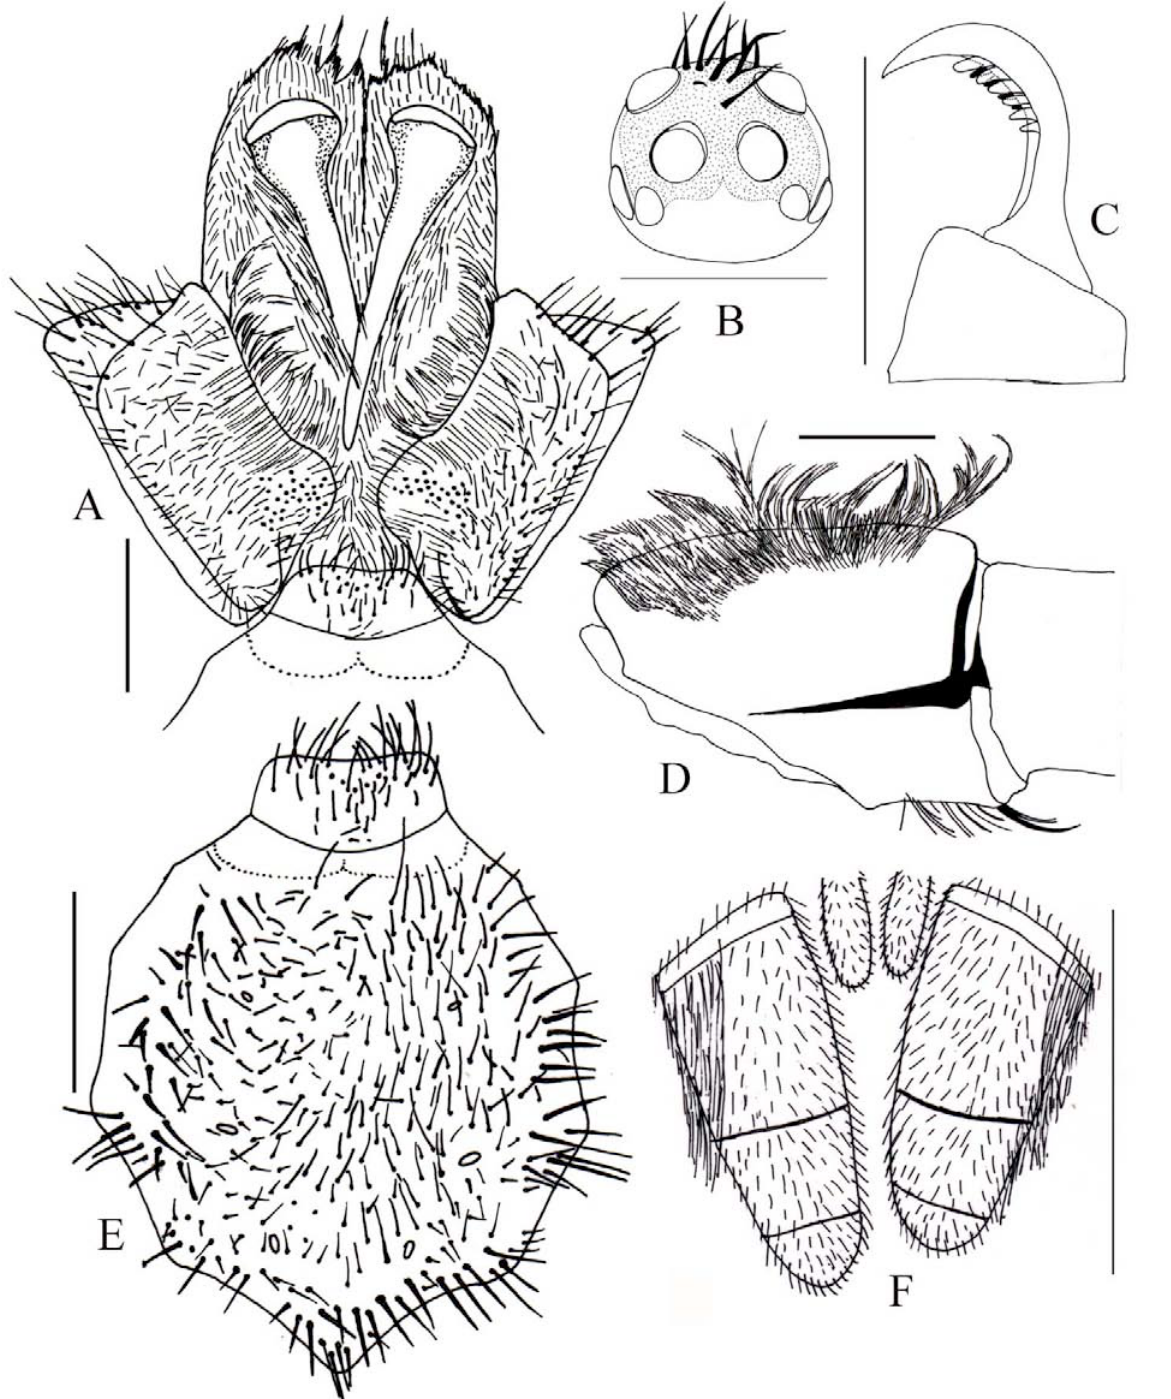
Figure 1. S. arthrapophysis male. A - Maxillae and labium, dorsal view; B - Arrangement of eyes, ocular tubercle; C - Claw, Figure 7. S. arthrapophysis male. A. Maxillae and labium, dorsal view. B. Arrangement of eyes, inner view showing small denticles (ca . 6/4) on inner/outer side; D - Maxilla, prolateral view; E - Sternum, dorsal view; F - Spinnerets, ventral view, . (scale for C = 0.5mm; A, B & D-F = ocular tubercle. C. Claw, inner view showing small denticles ( ca. 6/4) on inner/outer side. D. Maxilla, prolateral view. E. Sternum, dorsal view. F. Ventral view, spinnerets. (Scale for C =